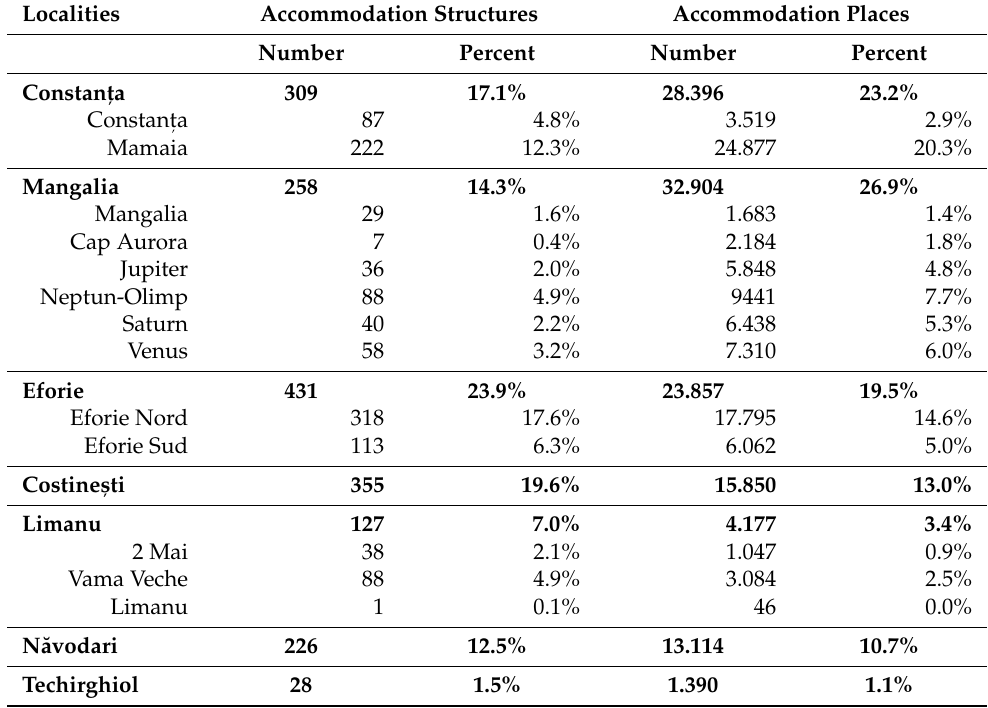
Table 3. Accommodation capacity in Constanta County, by locality (December 2018). Source: